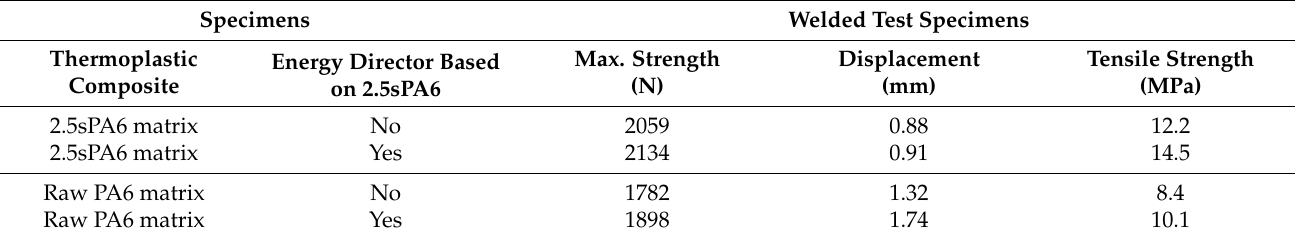
Table 3. Weld strength of composites manufactured with raw PA6 and 2.5sPA6. Evaluation of the improvements due to the energy director made with